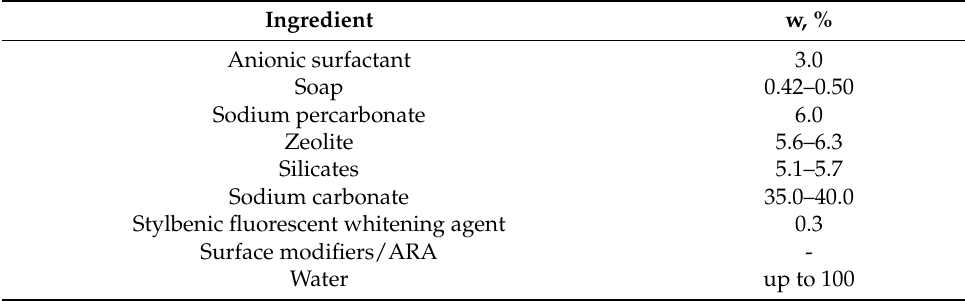
Table 1. Composition of basic detergent.